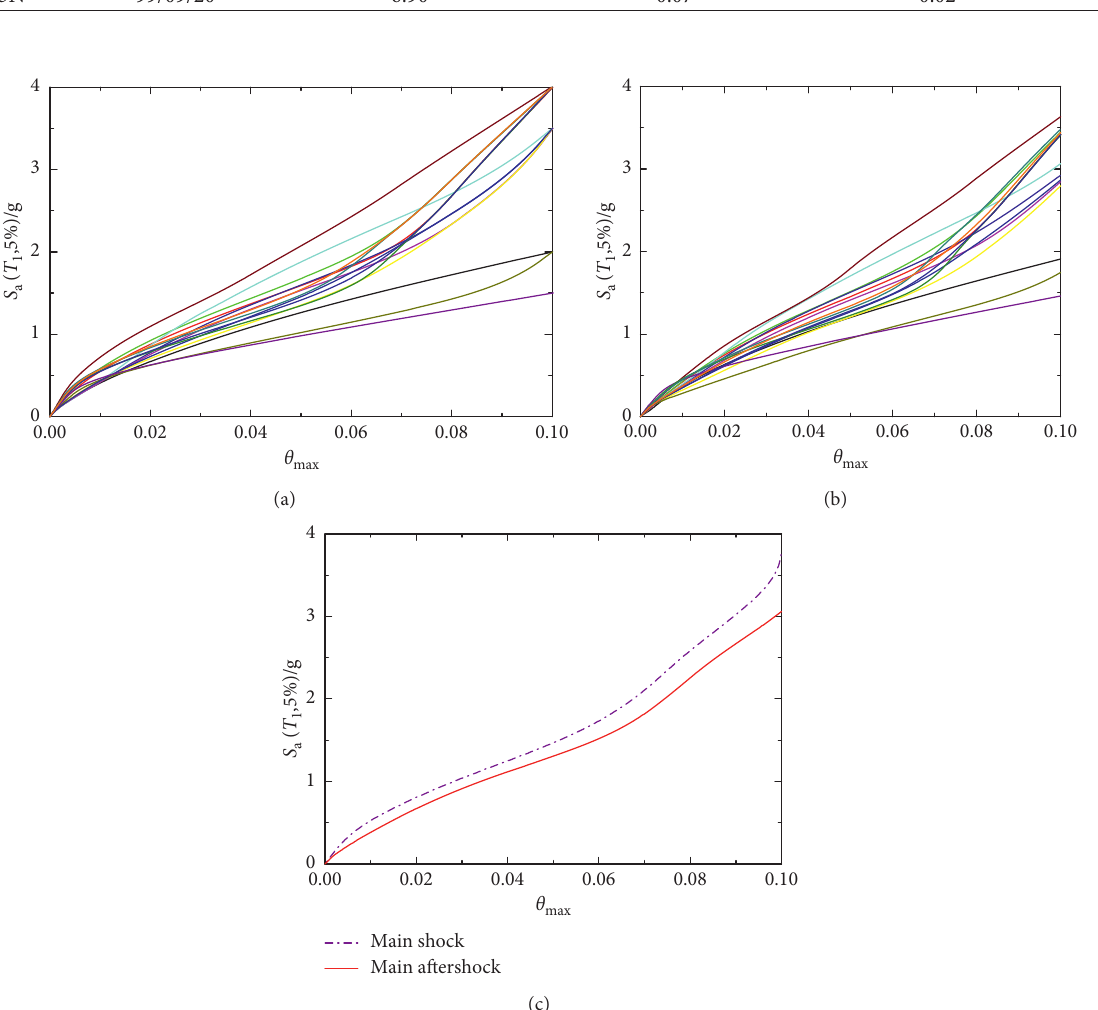
Figure 12: IDA curves. (a) The main shock ground motion. (b) The main aftershock sequence ground motion. (c) The median curve.